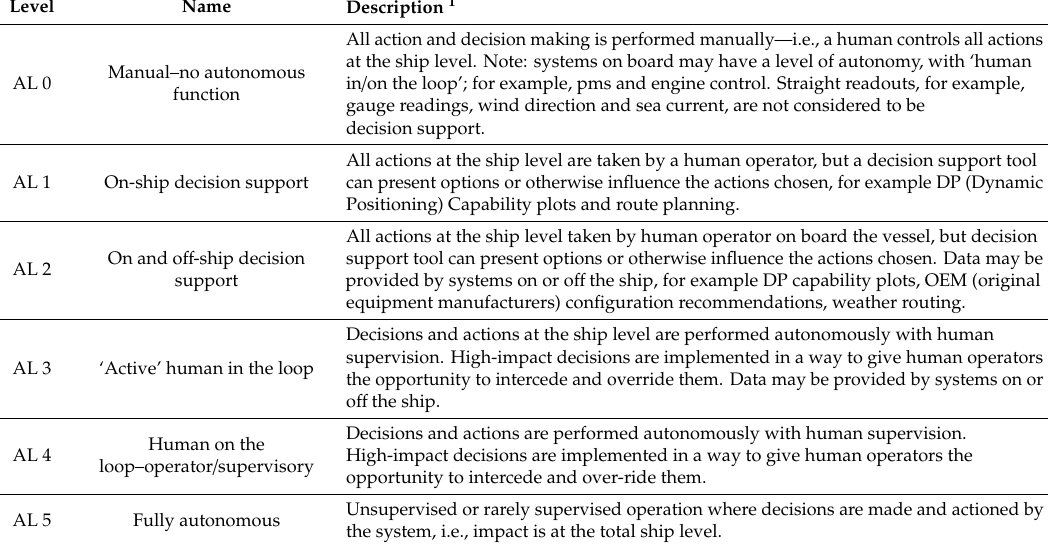
Table 2. MASS Level of Control Definitions according to the Lloyd’s Register guidance document on autonomous ships. Reproduced with the permission from the authors of ‘Cyber-enabled ships. ShipRight procedure—autonomous ships’, published by Lloyd’s Register, 2016 [13] (p. 2).